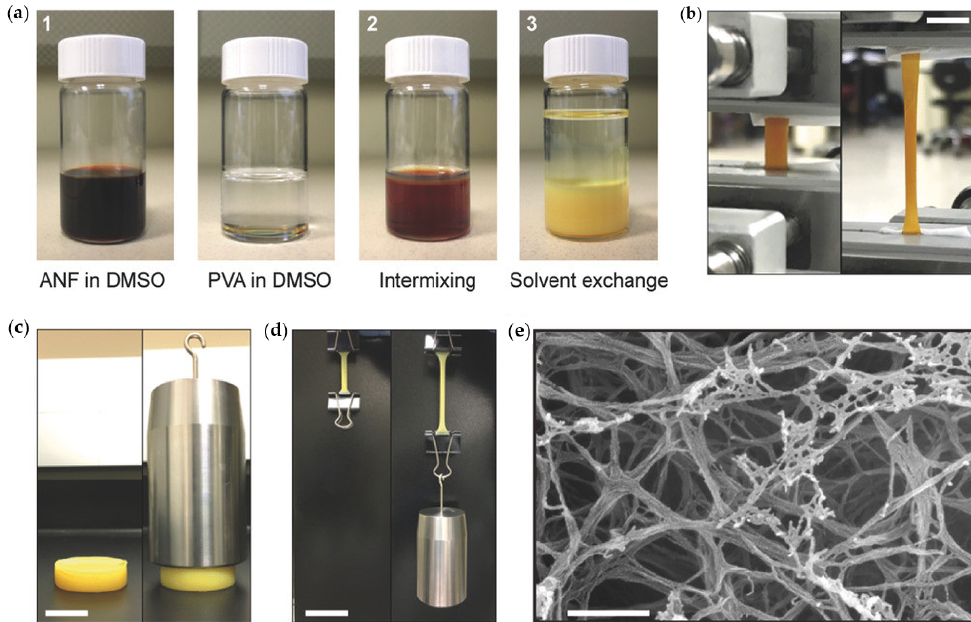
Figure 7. Nanofiber stretchable hydrogels made from aramid nanofibers and polyvinyl alcohol polymer. ( a ) Photographs of the polymer solutions and their mixing before electrospinning. ( b ) A hydrogel under tension with 0% (left) and 300% (right) tensile strains. Scale bar: 10 mm. ( c ) A hydrogel containing much less polyvinyl alcohol with (right) and without (left) a compressive load of 10 N. Scale bar: 30 mm. ( d ) The same sample in ( c ) with (right) and without (left) a tensile load of 10 N. Scale bar: 50 mm. ( e ) An SEM image of the same sample in ( c ) after drying. Scale bar: 300 nm. Reproduced from [115] with